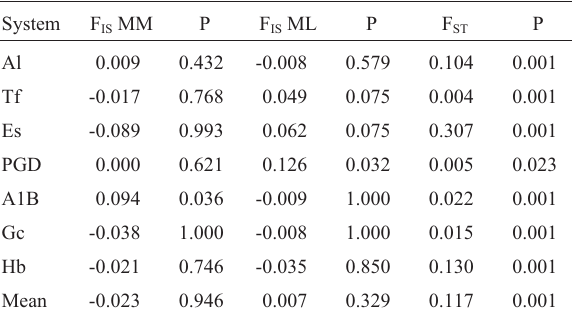
Table 3 - Inbreeding coefficient (F IS ) and fixation index (F ST ) for the protein systems in Mangalarga Marchador (MM) and Mangalarga (ML) breeds, with their probabilities (P).